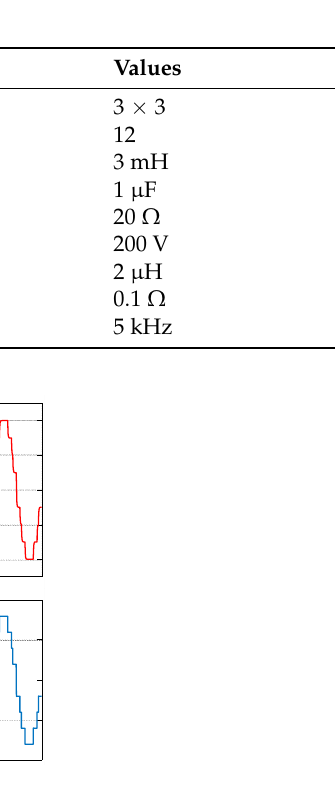
Figure 12. Simulation results of the lattice converter with harmonic elimination modulation.